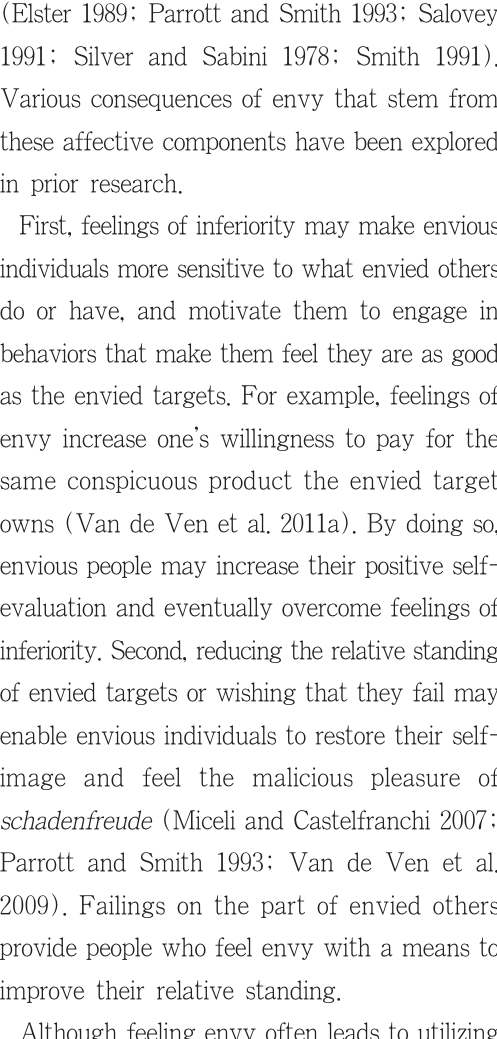
Social Comparison Theory and Interpersonal Contact: The Influence of Incidental Envy on Contacting Higher or Lower Status Others